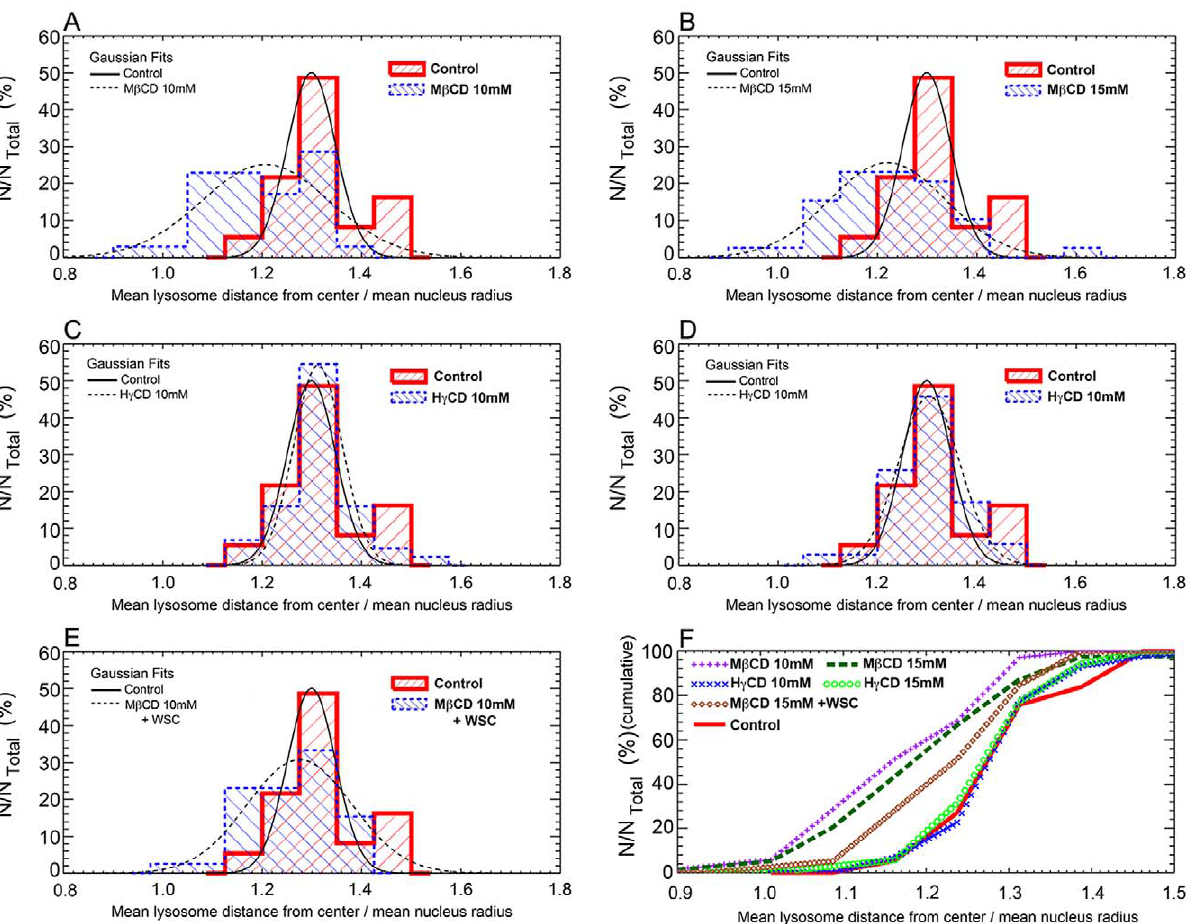
Figure 7. M b CD but not H c CD cell treatment leads to diminishment in lysosomal distribution near cell cortex. Quantitative analysis of lysosomal distribution, relative to cell nuclei, in 10 mM M b CD (A), 15 mM M b CD (B), 10 mM H c CD (C), 15 mM H c CD (D) or 15 mM M b CD followed by incubation with 0.05 mM WSC (E), treated cardiomyocytes in comparison to control non-treated cells. The mean distance between a lysosome and its respective cell center is represented by letter (D) and the mean lysosome distance (D) relative to the mean nucleus’ radius (R) was defined as the ratio D/R. Ratio values closer to one indicate lysosomes are close to perinuclear region whereas the opposite indicate lysosomes are more frequent at cell borders. This ratio D/R was measured for several groups of lysosomes associated with each nucleus in the different treatments. The results of this analysis are distributions of D/R values associated to each drug treatment, and are represented as histograms. The histogram for each specific drug treatment is represented with a blue dashed line, which is superposed to the control (non-treated) lysosomal distribution, represented with a red solid thick line. Overlaid Gaussian fits to each distribution were added in order to highlight the main statistical trend of each diagram. The x-axis of each graph represents the ratio D/R whereas the y-axis represents the percentage of analyzed nuclei from each treatment normalized by total cell number. (F) Cumulative frequency of the histograms. Purple plus signs represent M b CD 10 mM treated cells, dark green rectangles represent M b CD 15 mM treated cells, blue crosses represent H c CD 10 mM treated cells, light green circles represent H c CD 15 mM treated cells, brown diamonds represent cells replenished with cholesterol after previous depletion and red continuous line represent control untreated cells. The Kolmogorov- Smirnov (KS) statistical test was performed to compare the cumulative frequency distributions. Statistically significant differences were obtained